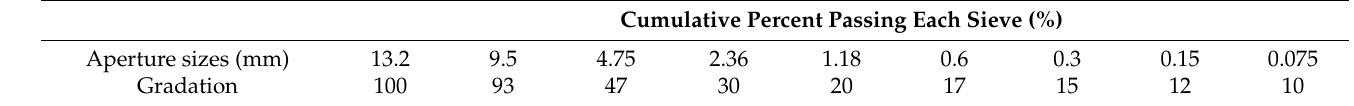
Table 2. Gradation of composite